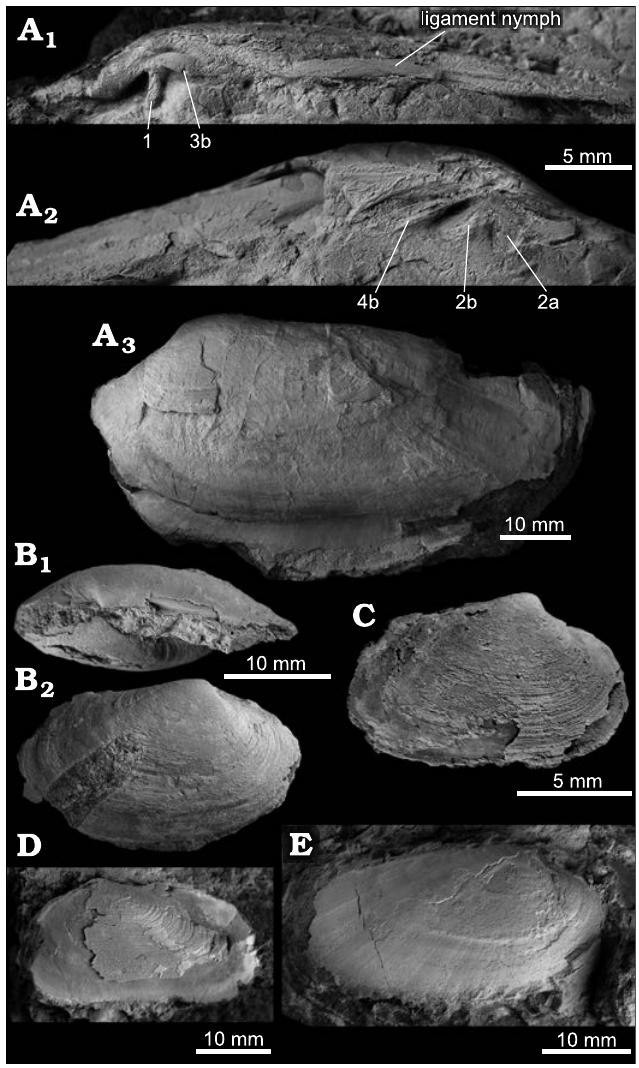
Fig. 13. The vesicomyid bivalve Archivesica ? sp. 1 from Upper Miocene seep deposits of the Amlang Formation in Pangasinan province, Luzon, Philippines. A . NRM Mo 192671, views on hinges of RV (A 1 ) and LV (A 2 ), cardinal teeth numbers indicated; and view on outer side of LV show- ing interior radial striations (A 3 ). B . NRM Mo 192418, small, articulated specimen, in dorsal view showing absence of lunule or lunular incision (B 1 ), and view on RV (B 2 ). C . NRM Mo 192419, very small specimen showing pallial line and posterior adductor muscle scar. D . NRM Mo 192672, small, isolated LV. E . NRM Mo 192670, medium-sized, isolated RV showing internal radial